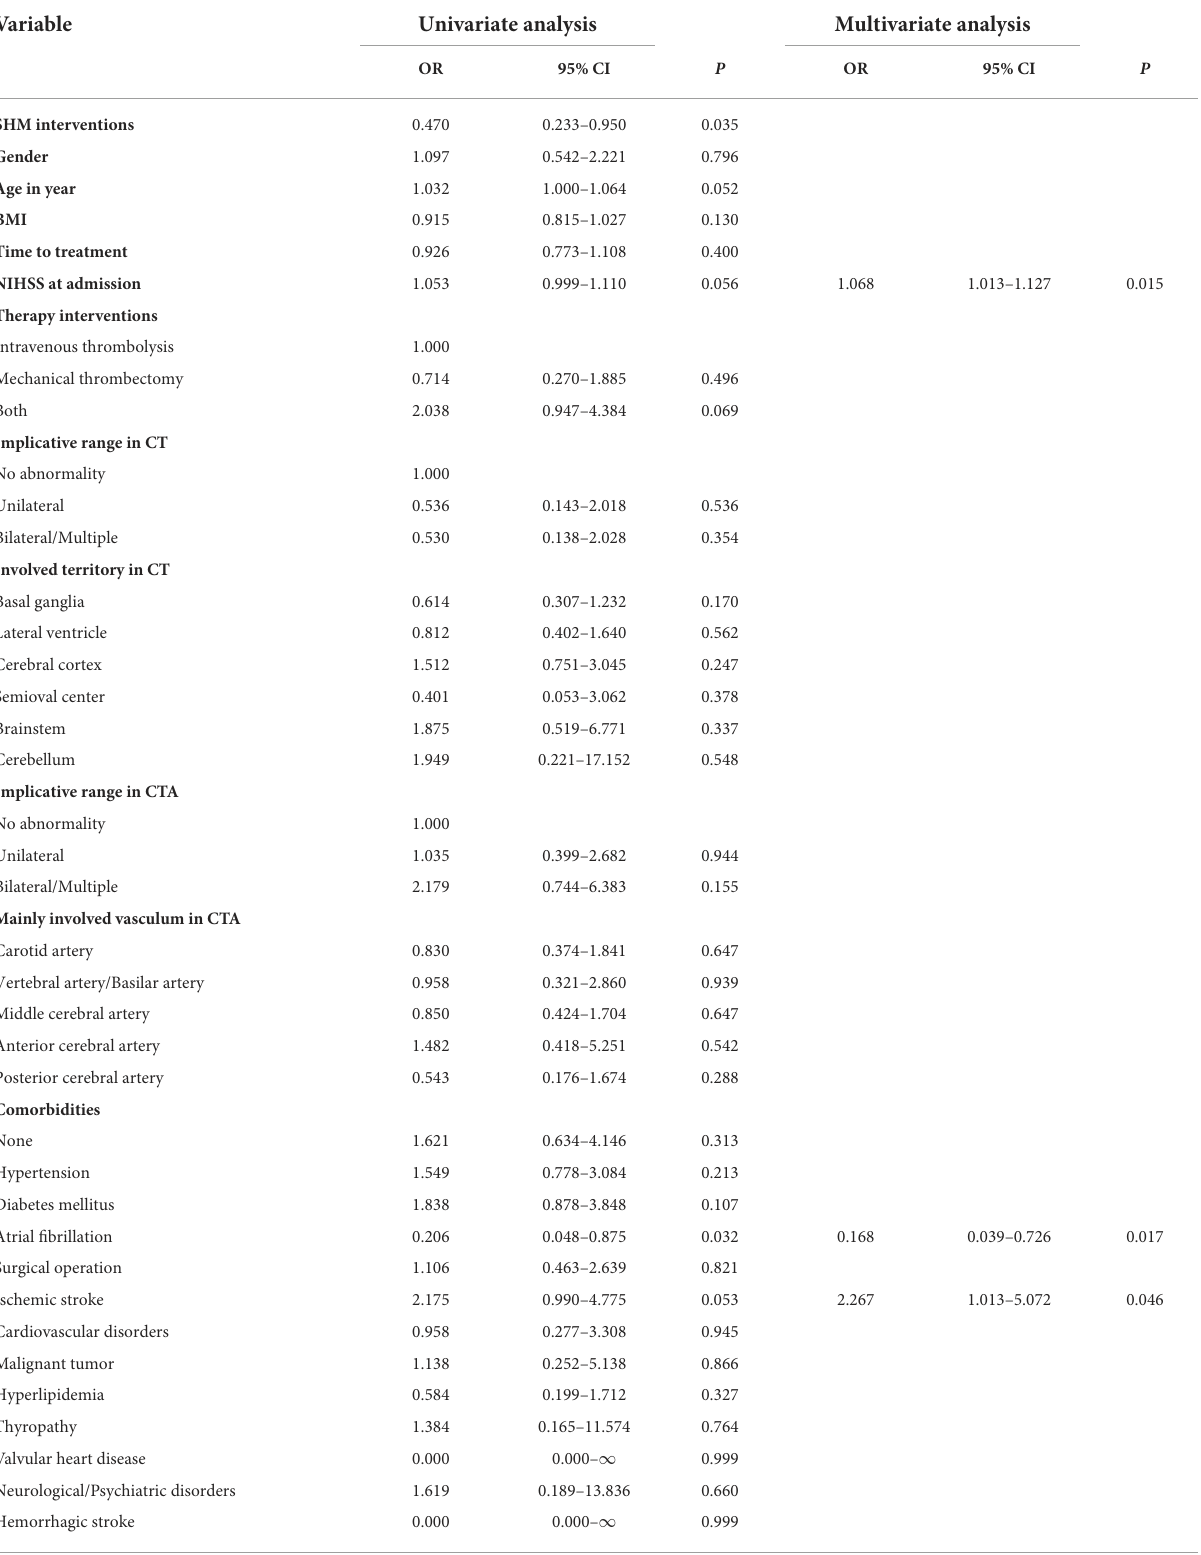
TABLE 2 Univariate and multivariate logistic analyses of variables for the prediction of recurrence rate of ischemic stroke. Variable Univariate analysis Multivariate